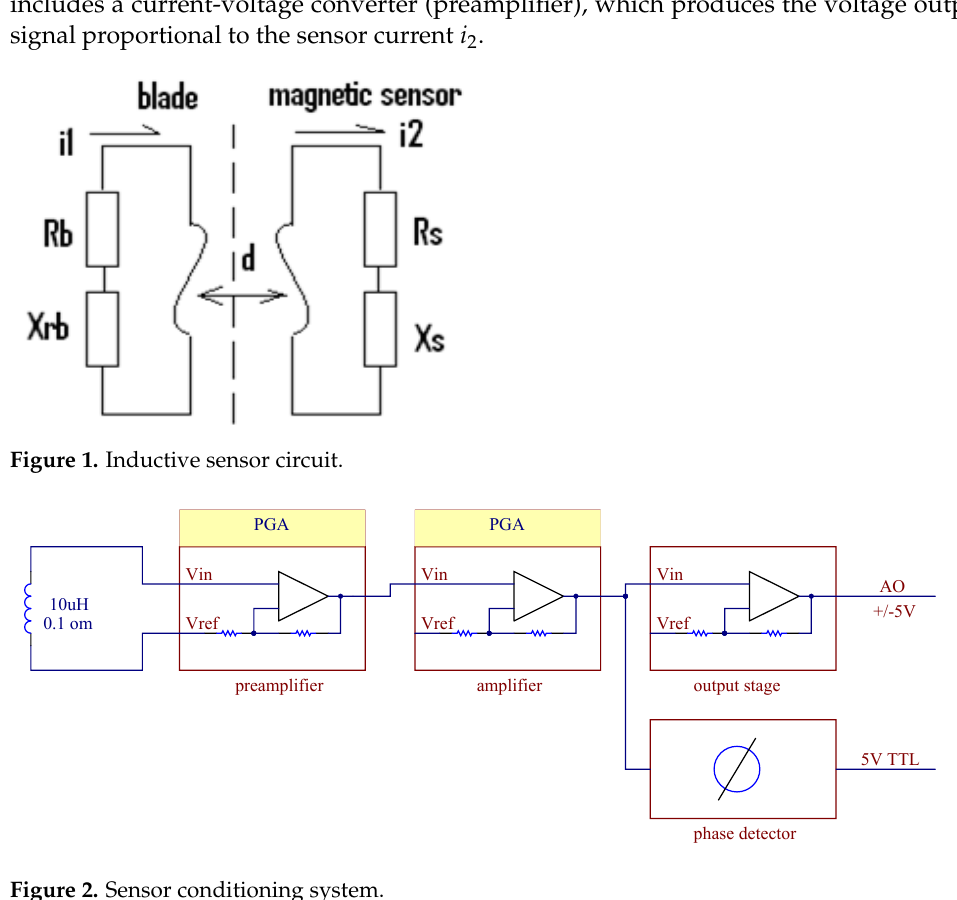
Figure 2. Sensor conditioning